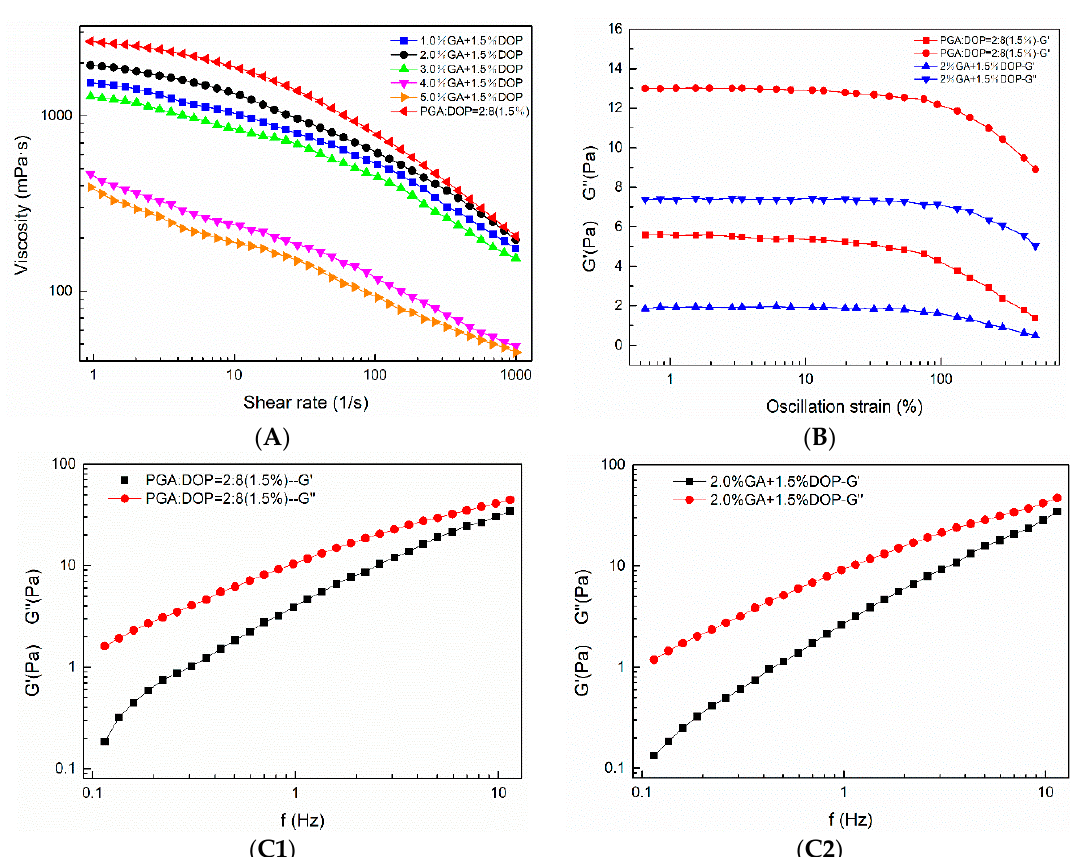
Figure 9. Rheological properties. ( A ) Steady-state flow curve. ( B ) Linear viscoelastic zone. ( C1 ) Dynamic frequency sweep of the emulsion prepared by PGA: DOP=2:8 (1.5%); ( C2 ) Dynamic frequency sweep of the emulsion prepared by 2.0% GA + 1.5% DOP.